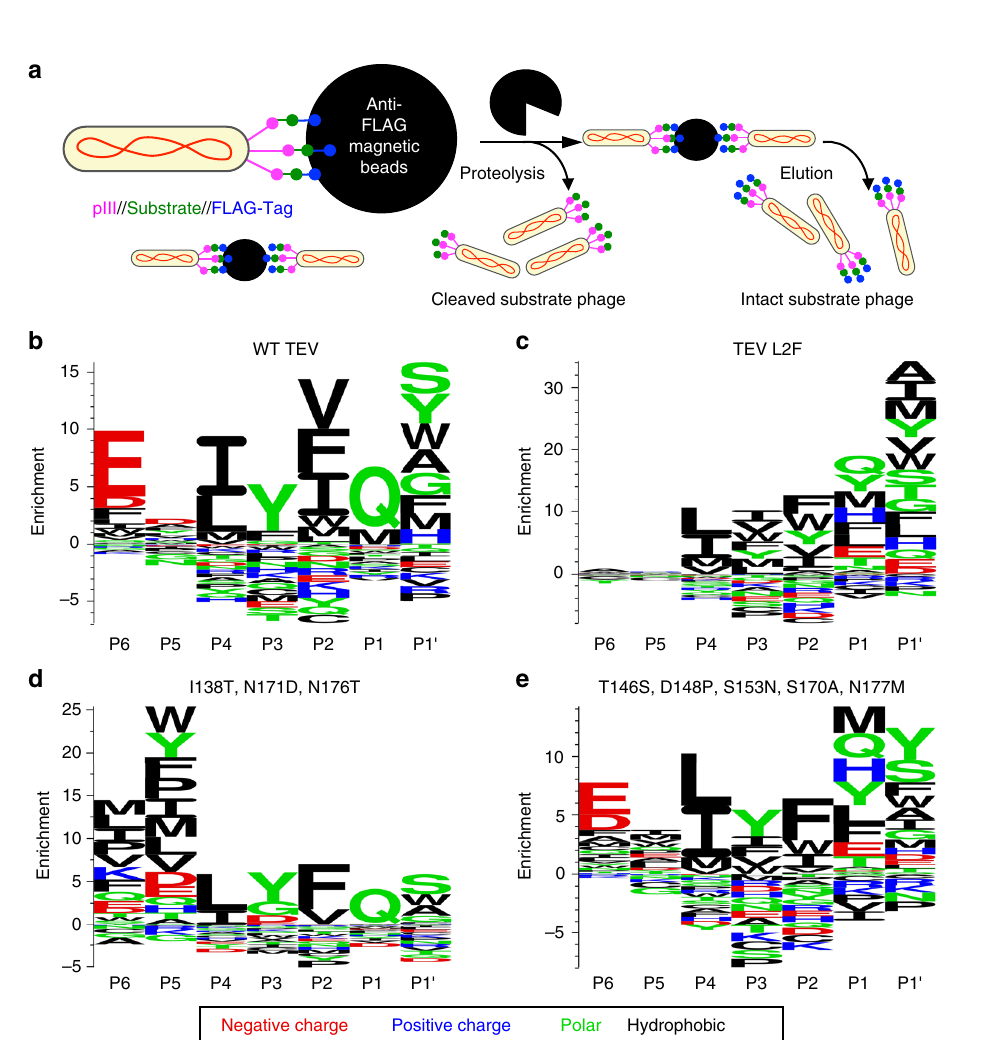
Fig. 3 Protease speci fi city pro fi ling. a Overview of phage substrate display. M13 bacteriophage libraries encode pIII fused to a FLAG-tag through a randomized protease substrate linker. These substrate phage are bound to anti-FLAG magnetic beads and treated with a protease to release phage that encode substrates that can be cleaved by the protease. The remaining intact substrate phage are eluted with excess FLAG peptide. The abundance of all substrate sequences within the cleaved and eluted samples is measured by high-throughput sequencing. b – e For all assayed proteases, phage substrate display was separately performed on seven libraries, each with a different single randomized position within the ENLYFQS motif. The results are displayed as sequence logos, with letter height proportional to enrichment in the cleaved versus eluted sample. Letters placed above the x -axis indicate protease acceptance and letters beneath the axis indicate rejection. b Wild-type TEV protease exhibits strong enrichment for the consensus motif EXLYFQS. c Evolved TEV L2F has broadened speci fi city at P6 and shifted speci fi city at P3, P1, and P1 ʹ in accordance with the HPLVGHM target substrate. d Mutations I138T, N171D, and N176T are suf fi cient to broaden P6 speci fi city. e Mutations T146S, D148P, S153N, S170A, and N177M shift speci fi city at both P1 and (Supplementary Fig. 13 and corresponding enrichment values in Supplementary Table 13). When we compare the speci fi city pro fi le of evolved TEV L2F (Fig. 3c) to that of wild-type TEV, a number of differences are apparent: TEV L2F shows a shifting of P3 speci fi city towards